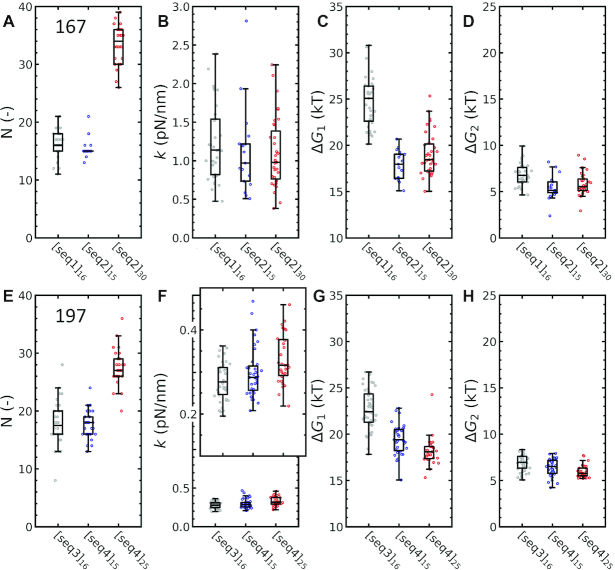
The unstacking energy, but not the stiffness of the fiber, depends on the linker DNA sequence. Force–extension curves of three fibers with either a different linker DNA sequences or a different number of repeats (denoted seq1–4, see Materials and Methods) were fitted to equation 15. (A) The number of nucleosomes N that were fitted largely reproduced the number of 601 repeats in the 167 NRL DNA substrates. Note that curves from seq2 were more stringently selected for the number of nucleosomes, yielding a narrower distribution. (B) The number of 601 repeats did not affect stiffness \documentclass[12pt]{minimal}
\usepackage{amsmath}
\usepackage{wasysym}
\usepackage{amsfonts}
\usepackage{amssymb}
\usepackage{amsbsy}
\usepackage{upgreek}
\usepackage{mathrsfs}
\setlength{\oddsidemargin}{-69pt}
\begin{document}
}{}$k$\end{document} (P = 0.92) nor did the sequence (P = 0.20). (C) Linker DNA sequence, however, significantly affected the unstacking energy \documentclass[12pt]{minimal}
\usepackage{amsmath}
\usepackage{wasysym}
\usepackage{amsfonts}
\usepackage{amssymb}
\usepackage{amsbsy}
\usepackage{upgreek}
\usepackage{mathrsfs}
\setlength{\oddsidemargin}{-69pt}
\begin{document}
}{}$\Delta {G_1}$\end{document} by approximately 7 kBT (P < 0.005). The number of nucleosomes did not change \documentclass[12pt]{minimal}
\usepackage{amsmath}
\usepackage{wasysym}
\usepackage{amsfonts}
\usepackage{amssymb}
\usepackage{amsbsy}
\usepackage{upgreek}
\usepackage{mathrsfs}
\setlength{\oddsidemargin}{-69pt}
\begin{document}
}{}$\Delta {G_1}$\end{document} (P = 0.09). (D) Unwrapping energy \documentclass[12pt]{minimal}
\usepackage{amsmath}
\usepackage{wasysym}
\usepackage{amsfonts}
\usepackage{amssymb}
\usepackage{amsbsy}
\usepackage{upgreek}
\usepackage{mathrsfs}
\setlength{\oddsidemargin}{-69pt}
\begin{document}
}{}$\Delta {G_2}$\end{document} was not affected by either nucleosome number (P = 0.43) or sequence (P = 0.05). Experiments on another group of NRL fibers yielded similar trends for (E) number of nucleosomes, (F) \documentclass[12pt]{minimal}
\usepackage{amsmath}
\usepackage{wasysym}
\usepackage{amsfonts}
\usepackage{amssymb}
\usepackage{amsbsy}
\usepackage{upgreek}
\usepackage{mathrsfs}
\setlength{\oddsidemargin}{-69pt}
\begin{document}
}{}$k$\end{document} (seq: P = 0.09, N: P = 0.03), (G) \documentclass[12pt]{minimal}
\usepackage{amsmath}
\usepackage{wasysym}
\usepackage{amsfonts}
\usepackage{amssymb}
\usepackage{amsbsy}
\usepackage{upgreek}
\usepackage{mathrsfs}
\setlength{\oddsidemargin}{-69pt}
\begin{document}
}{}$\Delta {G_1}$\end{document} (seq: P < 0.005, N: P = 0.05), and (H) \documentclass[12pt]{minimal}
\usepackage{amsmath}
\usepackage{wasysym}
\usepackage{amsfonts}
\usepackage{amssymb}
\usepackage{amsbsy}
\usepackage{upgreek}
\usepackage{mathrsfs}
\setlength{\oddsidemargin}{-69pt}
\begin{document}
}{}$\Delta {G_2}$\end{document} (seq: P = 0.01, N: P = 0.04).